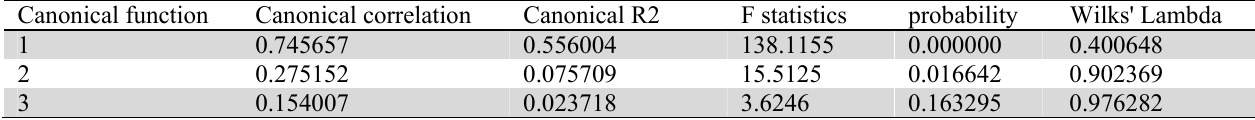
Canonical correlation